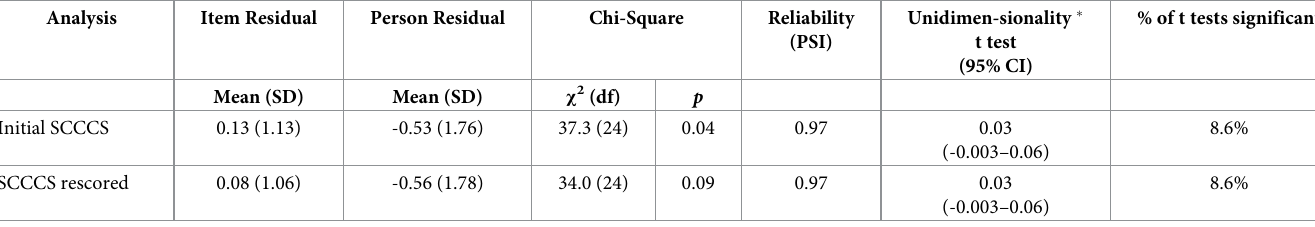
Rasch measurement theory. We further evaluated the scaling properties and construct validity of the SCCCS using RMT. Table 3 summarizes the RMT analyses. Fit to the RMT model was examined using fit residual mean values between the expected scores and the actual score. A perfect fit would be indicated by a summary mean of zero and standard deviation of ± 1: our item residual was of 0.13 ± 1.13 and person residual of -0.53 ± 1.76, both being Table 3. Summary rasch fit statistics and psychometric criteria of the SCCCS.